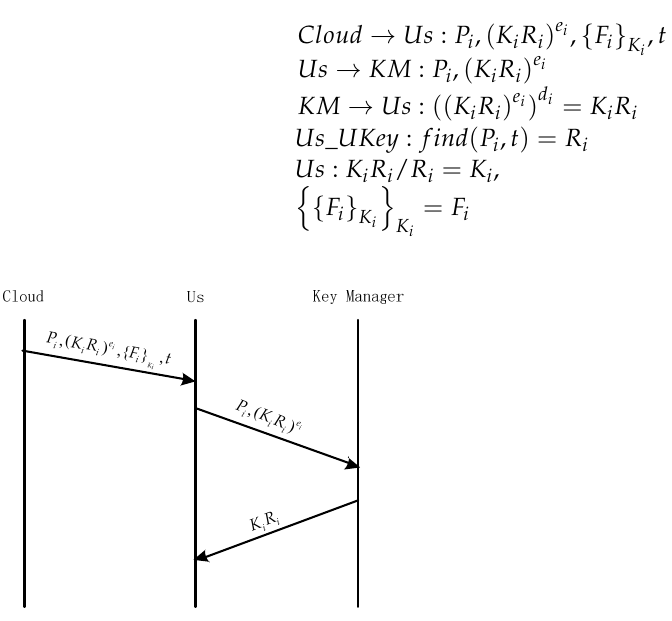
Figure 8. ADSS single-KM file download.